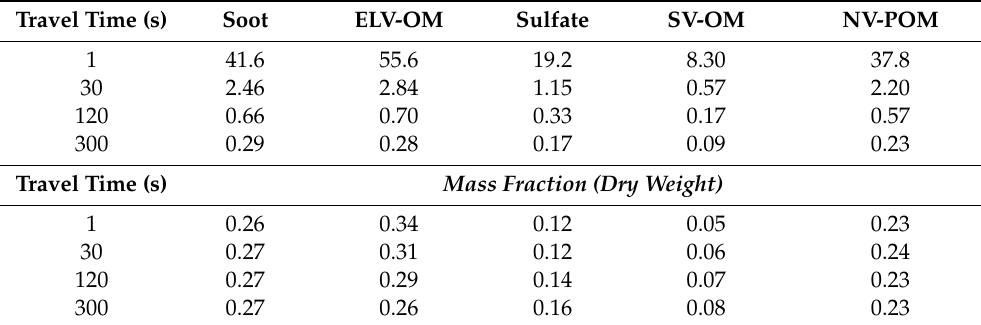
Table 2. Simulated chemical composition of ultrafine particles (dry weight) in the plume after di ff erent travel times. Mass concentration ( µ g · m − 3 ) in top part and mass fraction in bottom part. Components: Soot (corresponding to elemental carbon), ELV-OM—extreme low-volatility